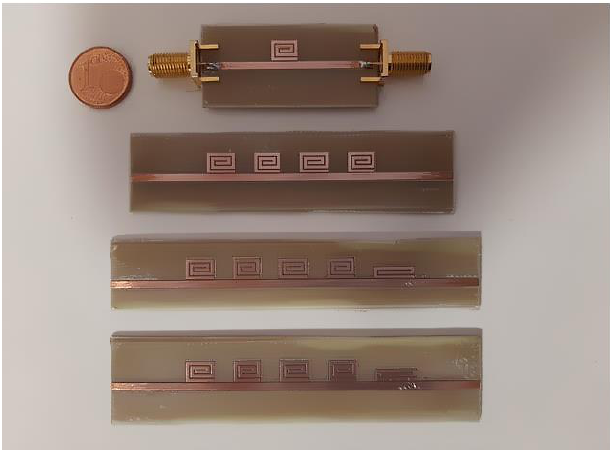
Figure 6. Photo of chipless tags equipped with di ff erent numbers of spiral resonators.